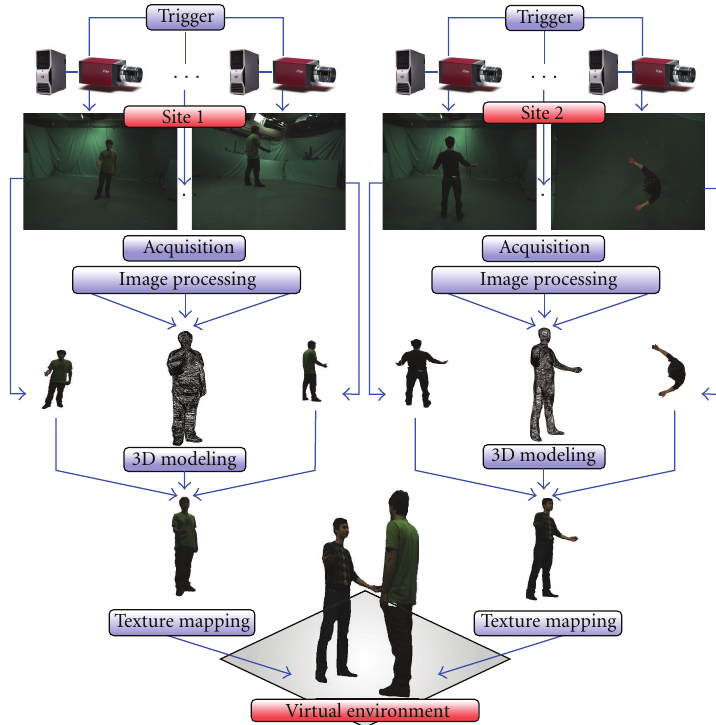
Figure 1: An illustration of the telepresence application